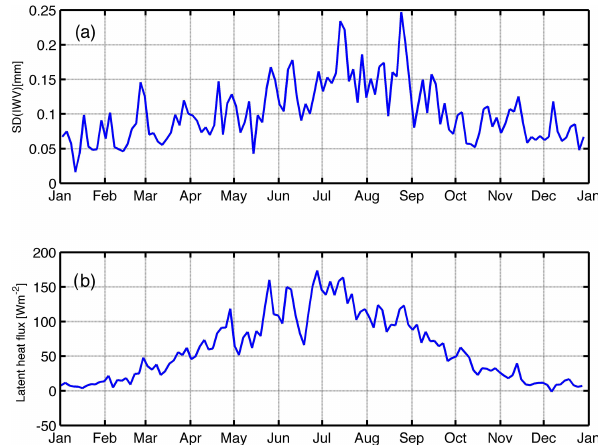
Figure 7. (a) Three-day averages of the magnitude of the short-term IWV variability (moving the SD of IWV with a 10min window) observed by TROWARA at Bern in 2010. Three-day averages of latent heat flux near Bern derived from MERRA-2 reanalysis data in 2010.